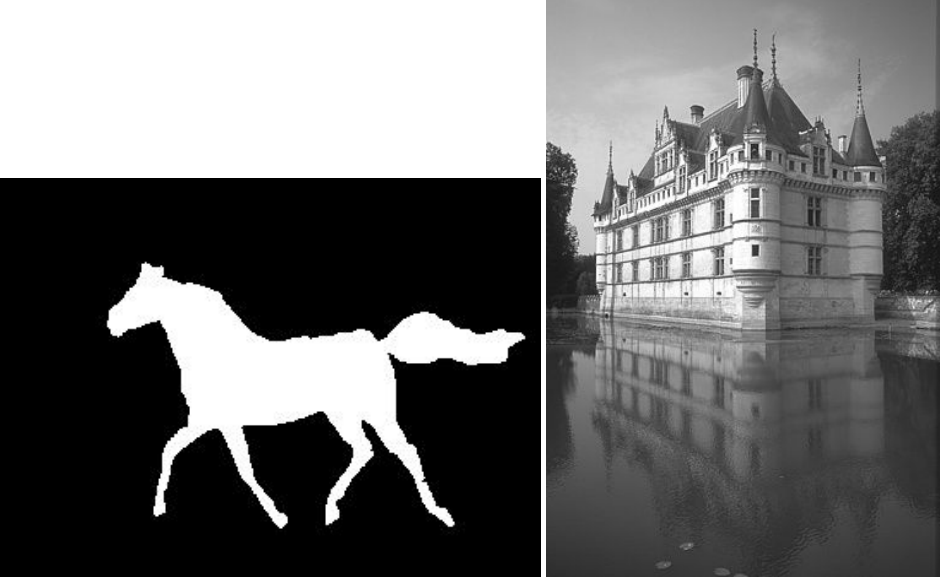
Figure 2. ( Left ): the binary shape image whose signed distance transform was used to train a shape decoder. ( Right ): the image used for training a denoising autoencoder